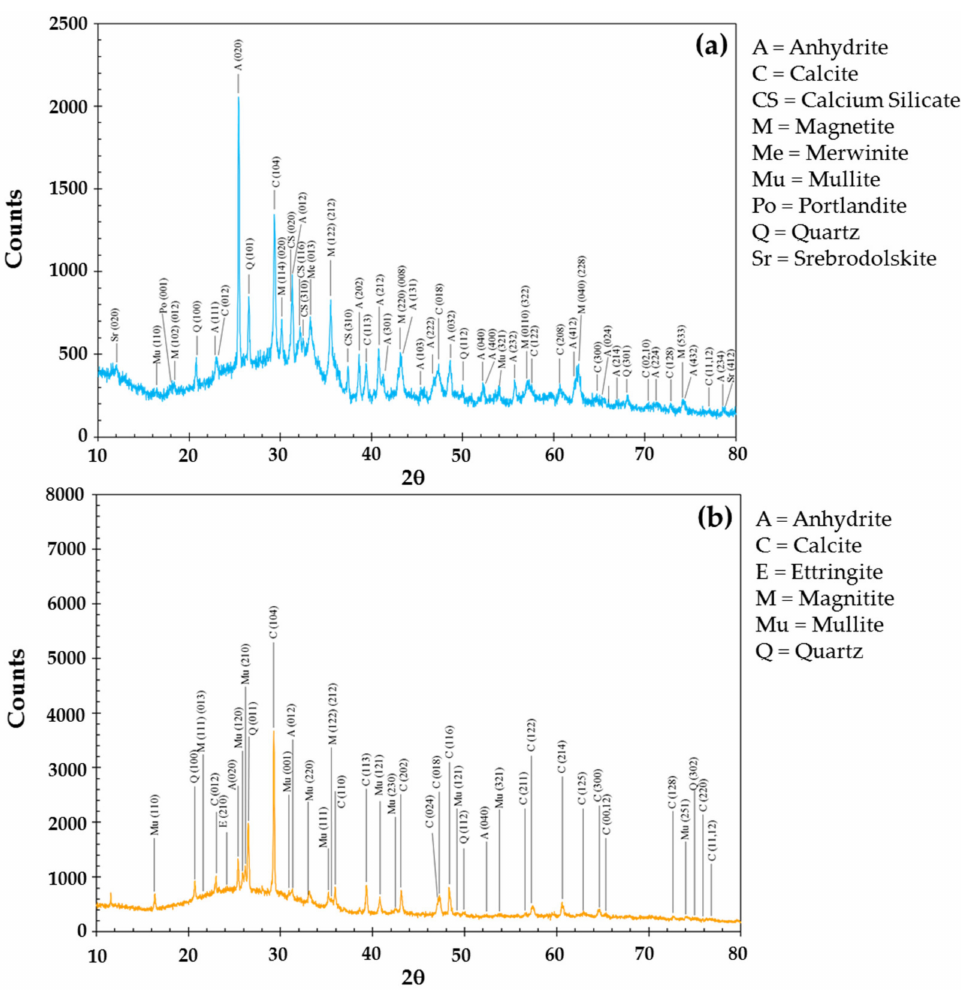
Figure 3. X-ray diffraction patterns of ( a ) fly ash and ( b ) cenospheres collected by the sink-float method using 1:10 fly ash-to-medium ratio, 2 h soaking